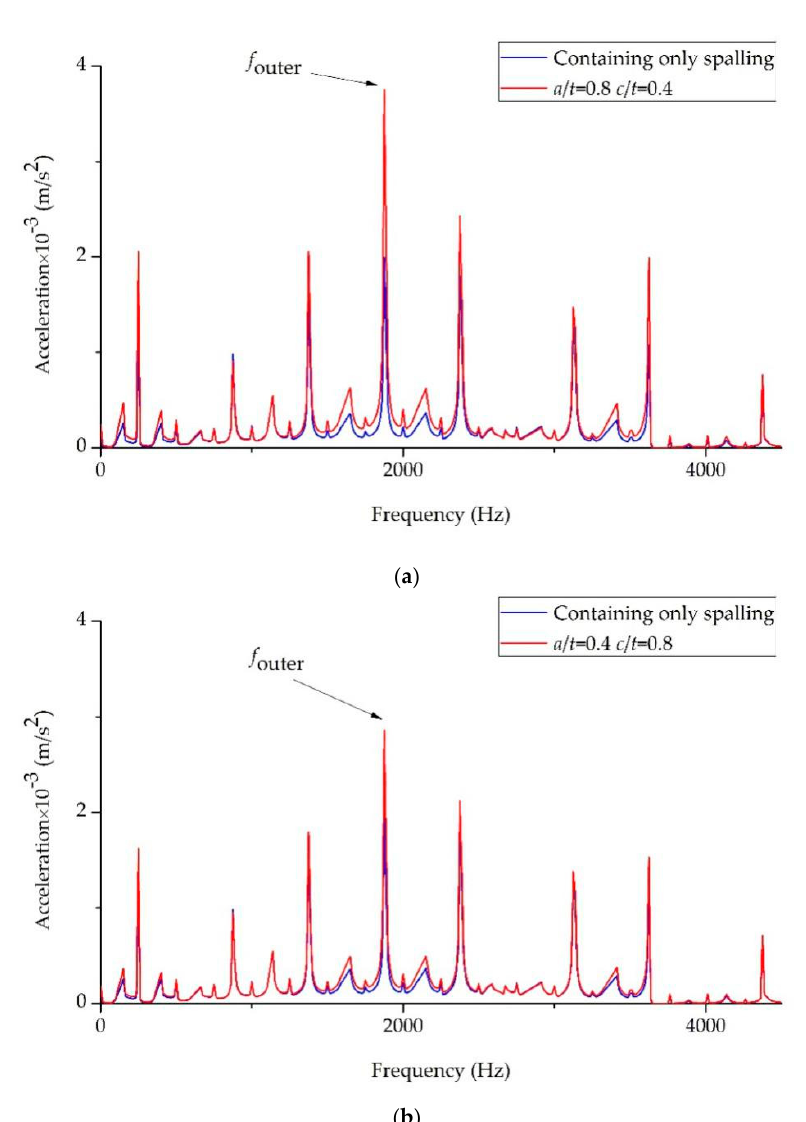
Figure 10. The frequency domain signals of bearing vibration response with ( a ) spalling faults only and crack depth potential as the main influencing factor ( a / t = 0.8 c / b = 0.4); ( b ) spalling faults only and crack width potential as the main influencing factor ( a / t = 0.4 c / b = 0.8).